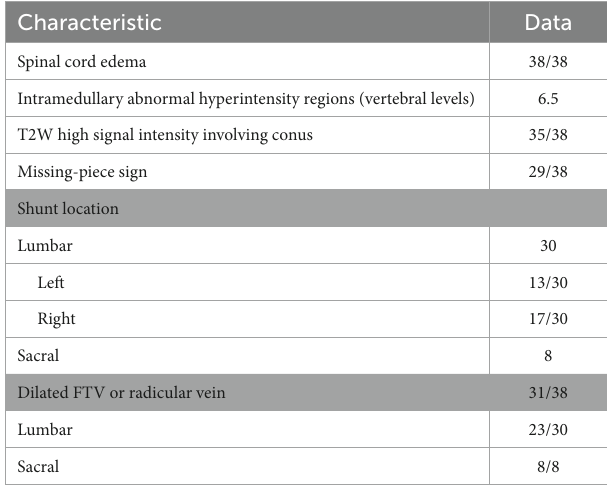
TABLE 2 Radiologic features of lumbosacral